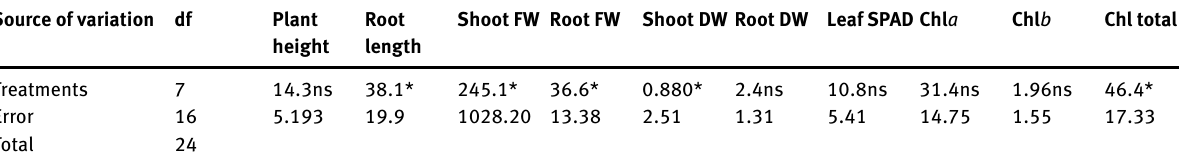
Table 2: Analysis of variance of physiochemical traits of lettuce under foliar application of treatments Source of variation